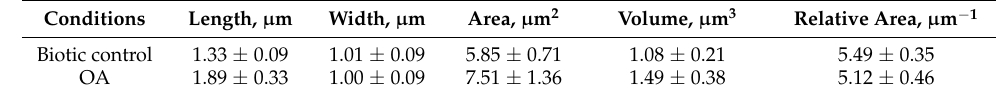
Figure 4. Phase-contrast microscopy (×1000) of R. rhodochrous IEGM 757 cells (( a ), biotic control) in the presence of OA ( b ). Bars: 4 µm. Table 1. Morphometric parameters of R. rhodochrous IEGM 757 cells.